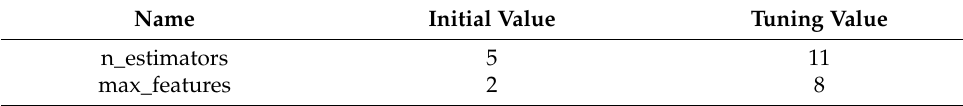
Table 11. RF algorithm tuning results.